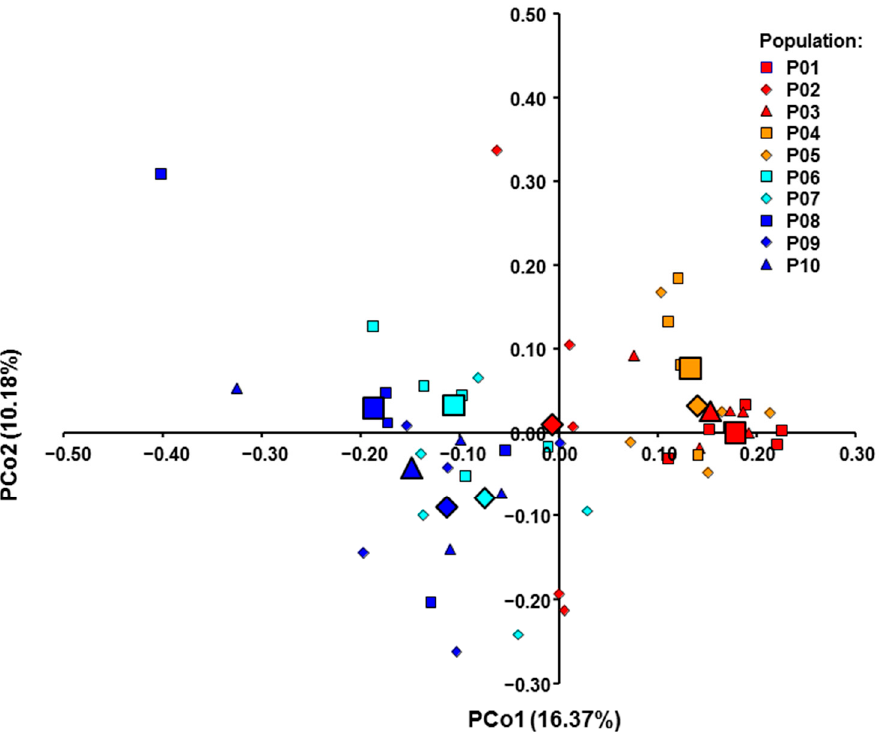
Figure 4. PCoA of the investigated Micromeria croatica populations from Croatia (Cr1–Cr5), Bosnia and Herzegovina (BH1–BH4), and Montenegro (Mn).